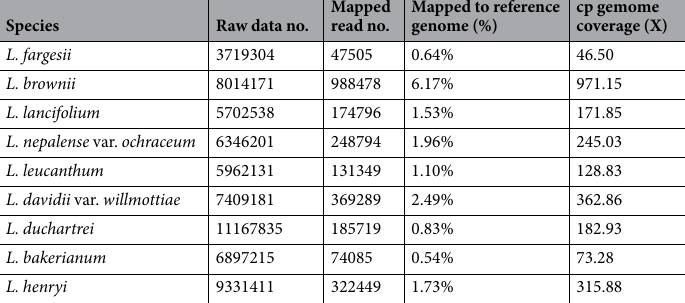
Table 1. Summary of the sequencing data for nine Lilium